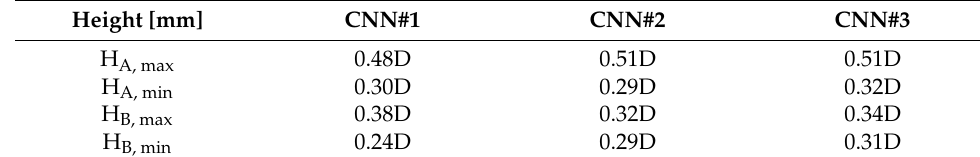
( b ) Figure 19. ( a ) Forging force–punch patch curves and ( b ) die wear distribution for CNN#1, CNN#2, CNN#3, and cylindrical billet preforms, respectively.